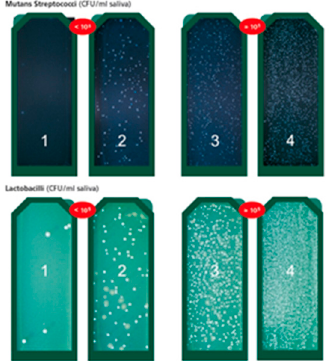
Figure 1. Interpretation chart of the bacteria density of the CRT ® kit: light green agar represented LB density; dark blue agar represented the MS density. Density less than 10 5 CFU indicated low caries risk; density higher than 10 5 CFU indicated a higher caries risk for both for MS and LB. The bacteria density was recoded as 1, 2, 3, or 4 for data analysis.